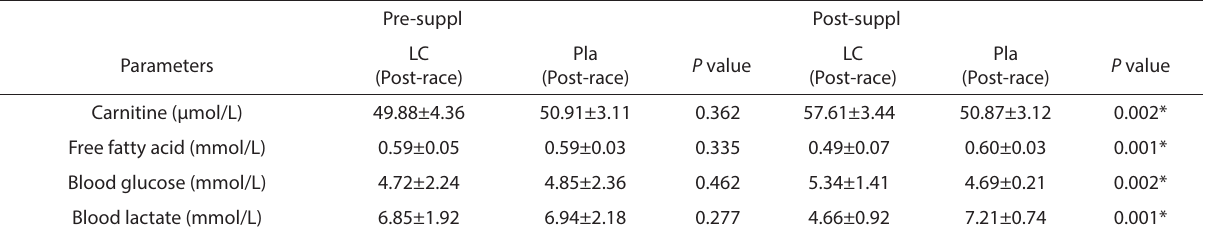
Table 5. Physiological responses to the race between groups before and after